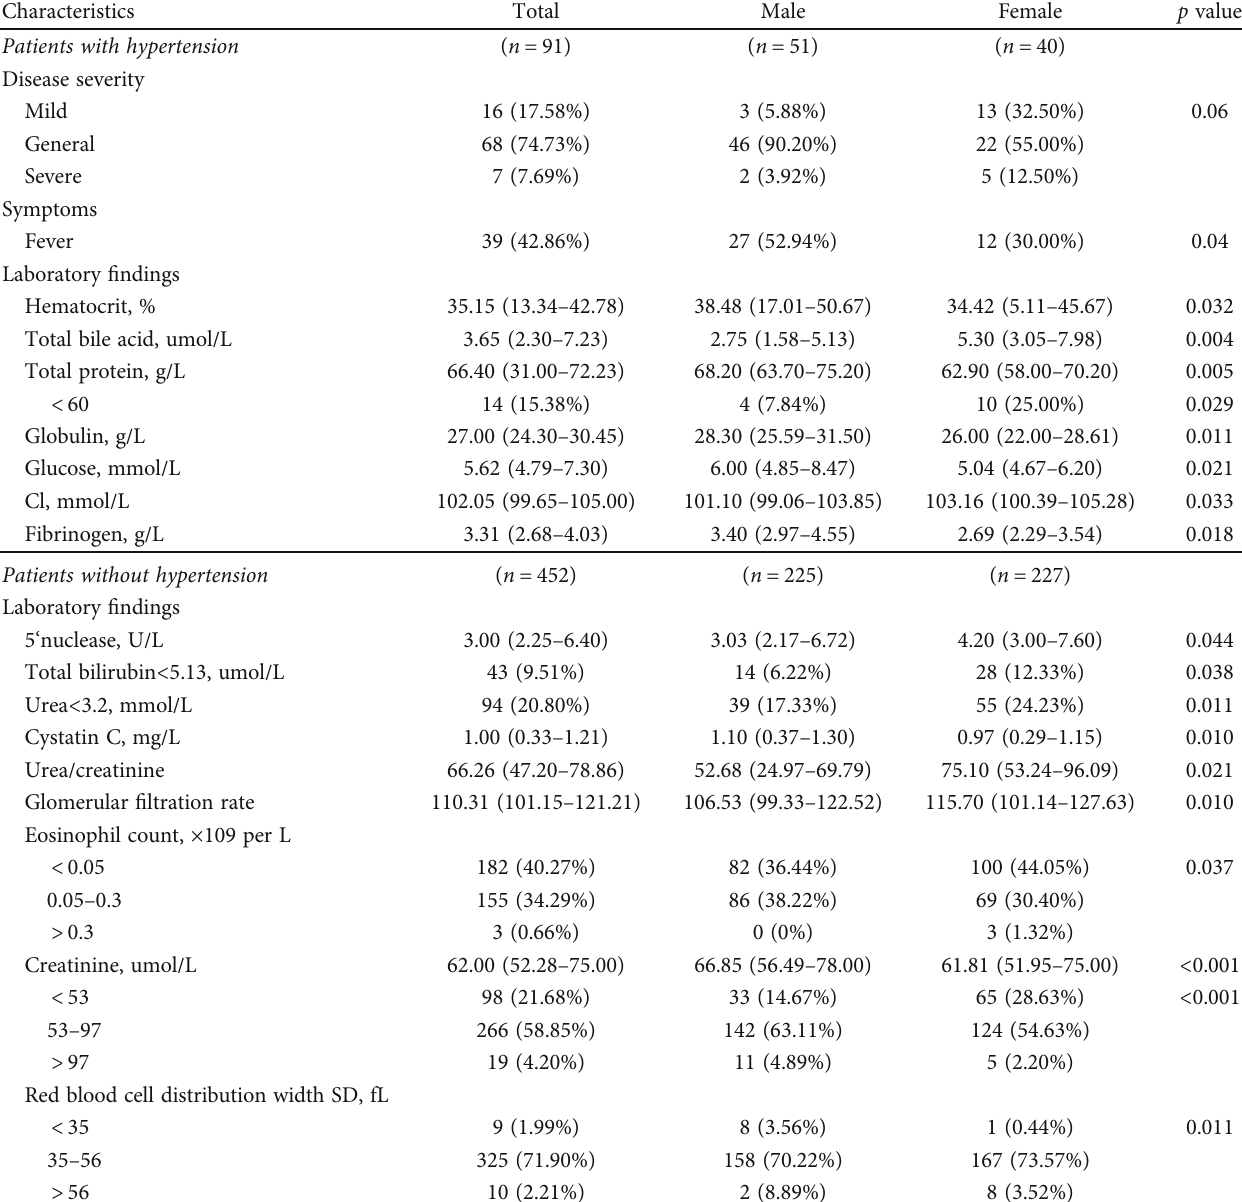
Table 3: Clinical characteristics and laboratory fi ndings in di ff erent gender of hypertensive and non-hypertensive COVID-19 patients.